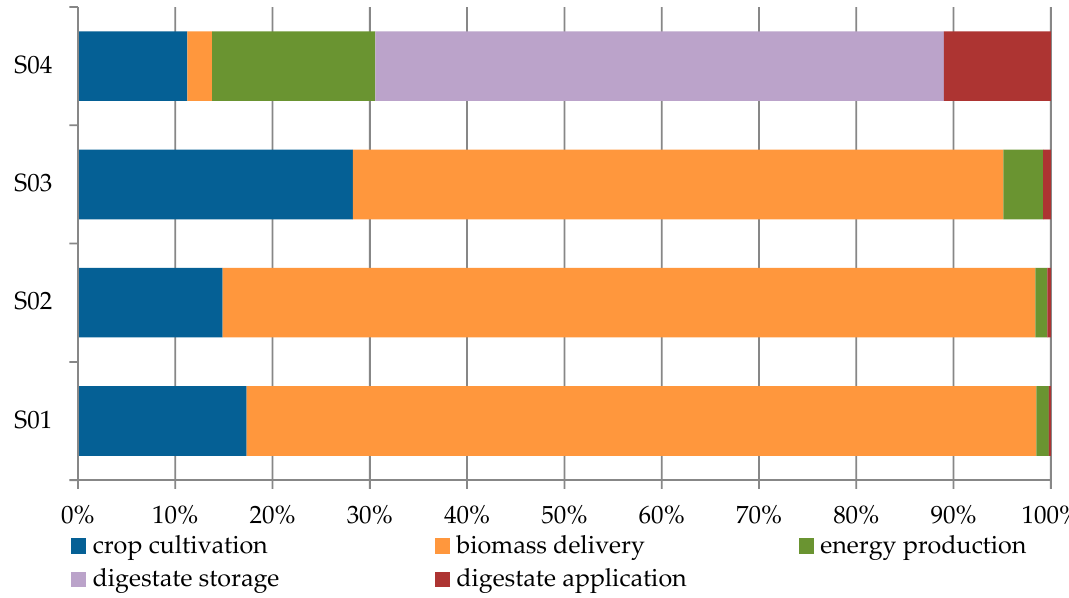
Figure 2. The share of unit processes in the environmental impact of a whole production chain of investigated biogas plants, expressed in cumulative eco-indicator (Pt) for the functional unit, based on SimaPro calculations.